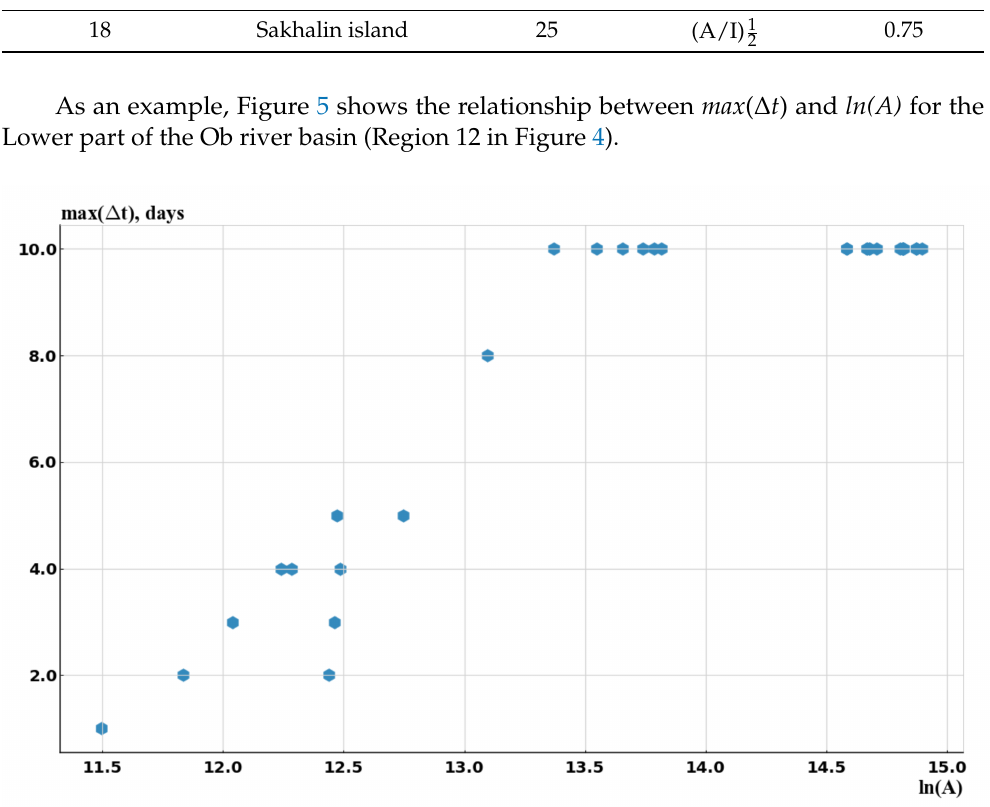
Figure 5. Dependence of good forecasts water levels maximum lead-time max ( ∆ t ) on catchment area logarithm ln(A) for the basin of the Lower